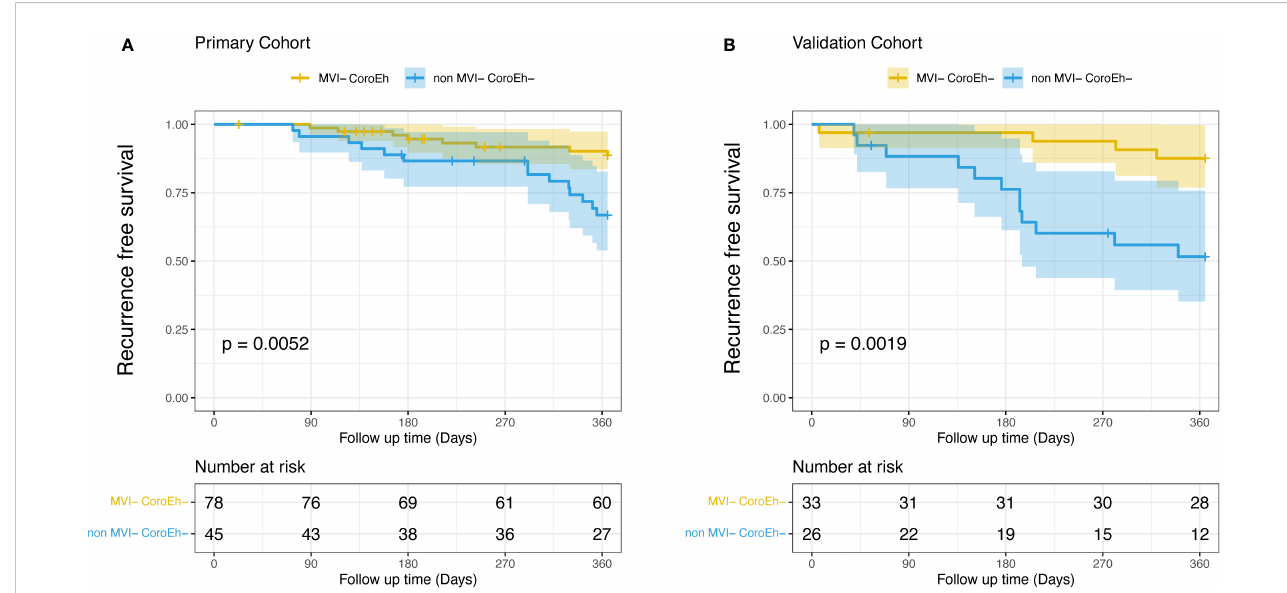
FIGURE 4 Kaplan-Meier plots show the impact of microvascular invasion (MVI) risk and coronal enhancement (CoroEh) status on early post-surgical recurrence- free survival. Patients without MVI or coronal enhancement (MVI − CoroEh − ) were compared to the pooled group of patients with MVI and/or coronal enhancement (non-MVI − CoroEh − ) in (A) the primary cohort and (B) the validation cohort. P -values are based on the log-rank